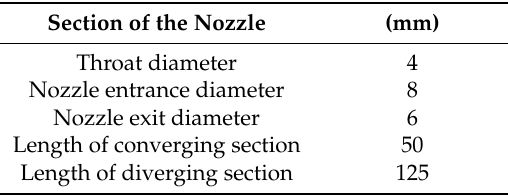
Table 2. Geometrical parameters of the